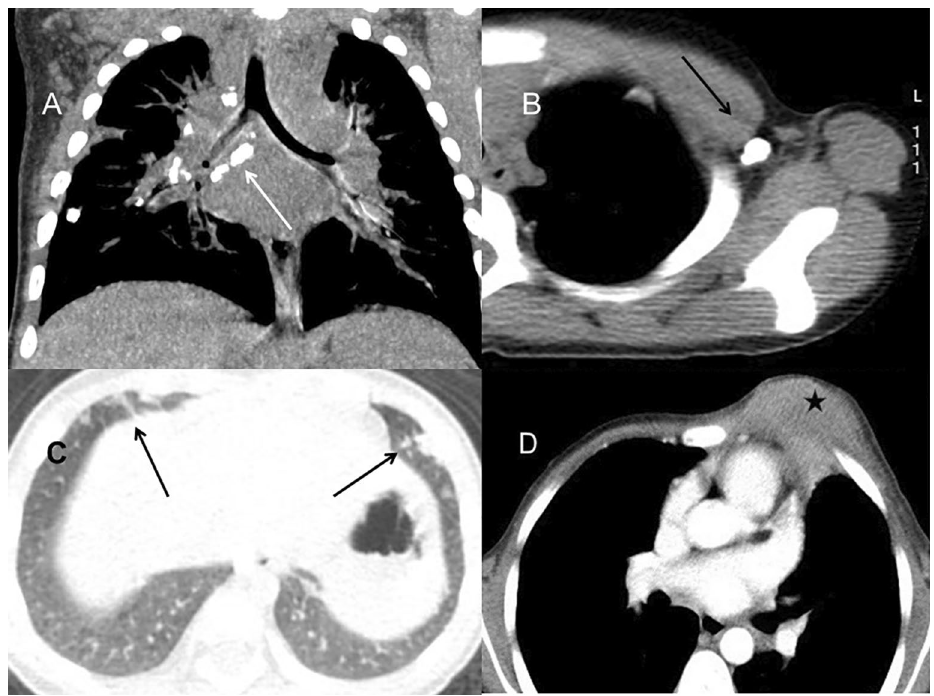
Figure 2. Pulmonary CT of BCG infection. ( A ) Coronal reformatted CT image of a 1-year-old boy demonstrated multiple nodular calcification within the mediastinal and hilar lymph nodes (long arrow). The calcified nodule in the right lower lobe was also found. ( B ) The left axillary calcification ipsilateral to the BCG injection site was found in a 1-year-old boy (long arrow). ( C ) Chest CT of a 9-month-old boy showed multiple pulmonary nodules in the bilateral lower lobe beneath the pleura (long arrow). ( D ) A 8-month-old boy with chest wall invasion. CT demonstrated a large chest wall mass with patchy areas of low density inside, suggesting the forming of abscess (star).